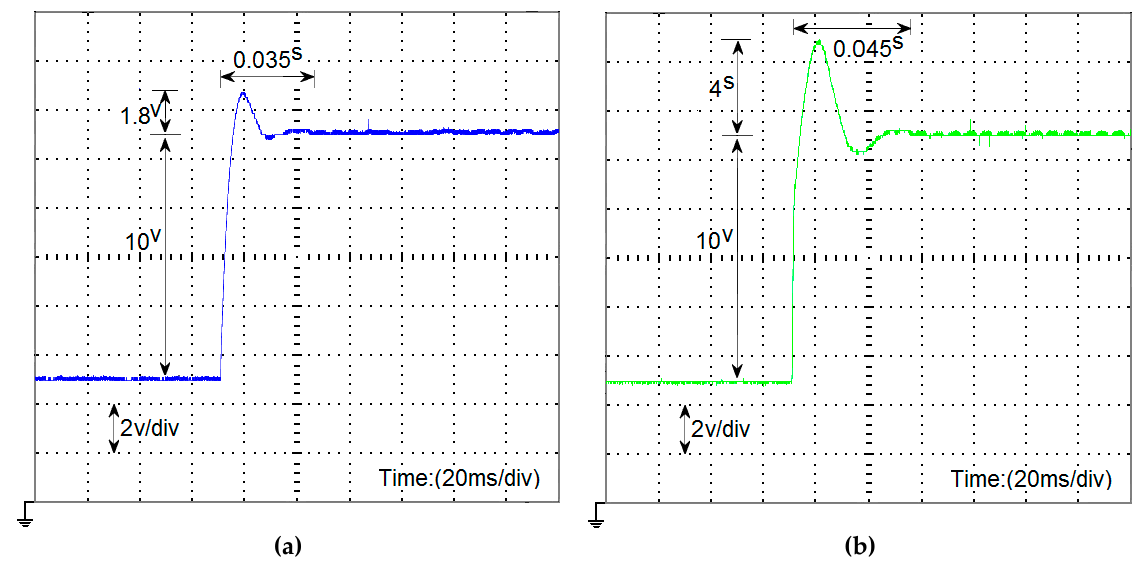
Figure 8. Comparison of the proposed and double-loop controllers during voltage reference changes. ( a ) Output voltage of the proposed adaptive PSMC (vertical scale is 2 V per square and time scale is 20 ms per square). ( b ) Output voltage of the double-loop standard SMC (vertical scale is 2 V per square and time scale is 20 ms per square).